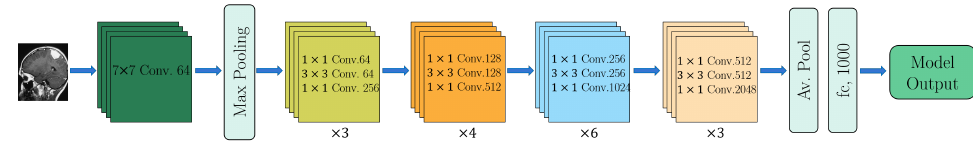
Figure 3. A basic block diagram representation of pre-trained ResNet50 architecture.